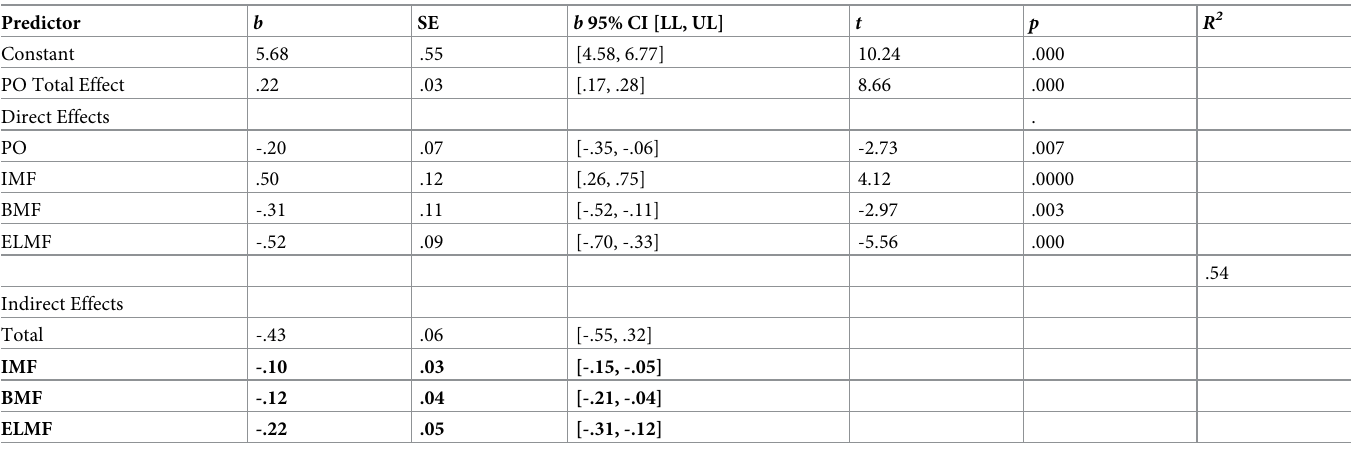
Table 15. Mediation effects of moral foundations on the relationship between political orientation health versus economic prioritization scale (N = 209). Predictor